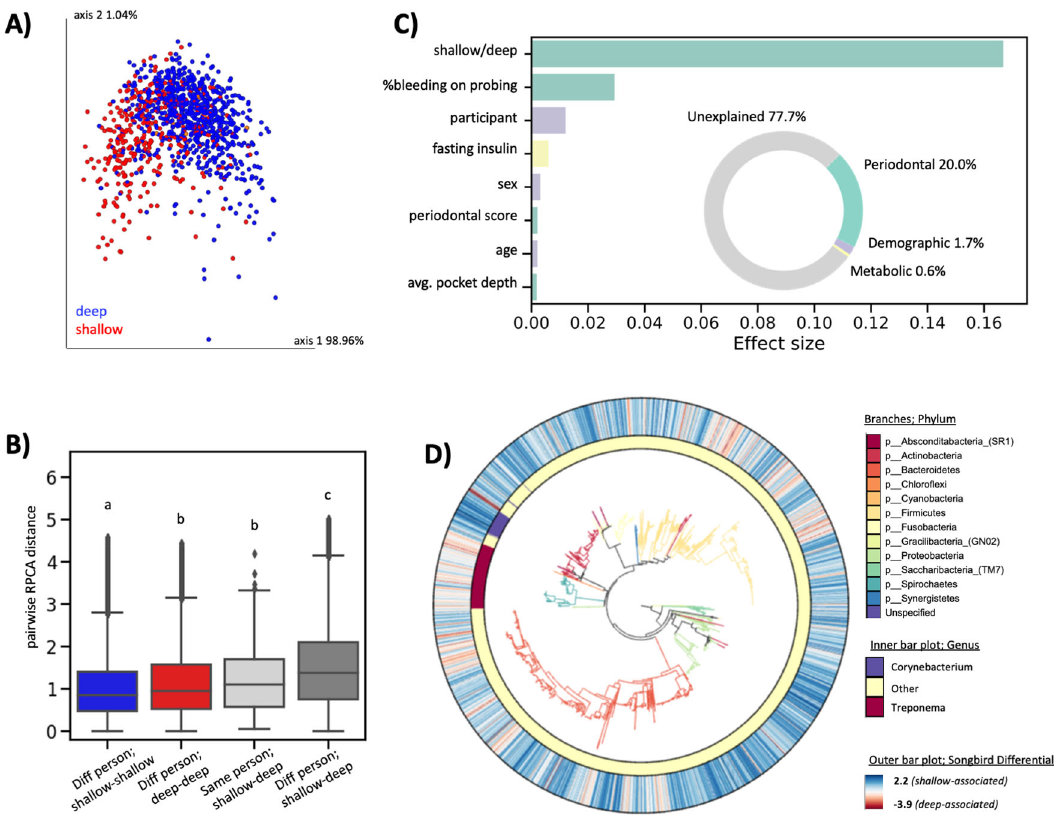
Fig. 2 Beta-diversity and redundancy analysis in subgingival plaque. A RPCA colored by periodontal pocket depth. Permanova pseudo-F statistic = 397.062, p -value < 0.001. B RPCA distance among pairwise samples; Subgingival plaque samples from shallow periodontal pockets of different people ( n = 308,505 pairs), subgingival plaque samples from deep periodontal pockets samples of different people ( n = 54,285 pairs), subgingival plaque samples from shallow versus deep periodontal pockets from the same person ( n = 322 pairs), subgingival plaque samples from shallow versus deep periodontal pockets from different people ( n = 259,058 pairs). Each group is signi fi cantly different from all other groups (one-way ANOVA with Tukey ’ s multiple corrections, p < 0.05). The box shows the quartiles of the dataset while the whiskers extend to show the rest of the distribution, except for points that are determined to be “ outliers ” using a method that is a function of the inter-quartile range. C Redundancy analysis (RDA) estimates the percent microbial diversity explained by each variable. Inset donut chart sums effect sizes by category; periodontal variables explained the majority of microbial variation (20.0%), followed by demographic variables (1.7%) and metabolic variables (0.6%). D Empress plot displaying ASV-level phylogeny with branches colored by phylum. Outer bar plot represents songbird differentials on a color scale where high values (blue color) are taxa associated with health, and low values (red color) are associated with disease. Inner bar plot highlights features from the genera Corynebacterium (blue) and Treponema (red), which have high and low Songbird differentials,